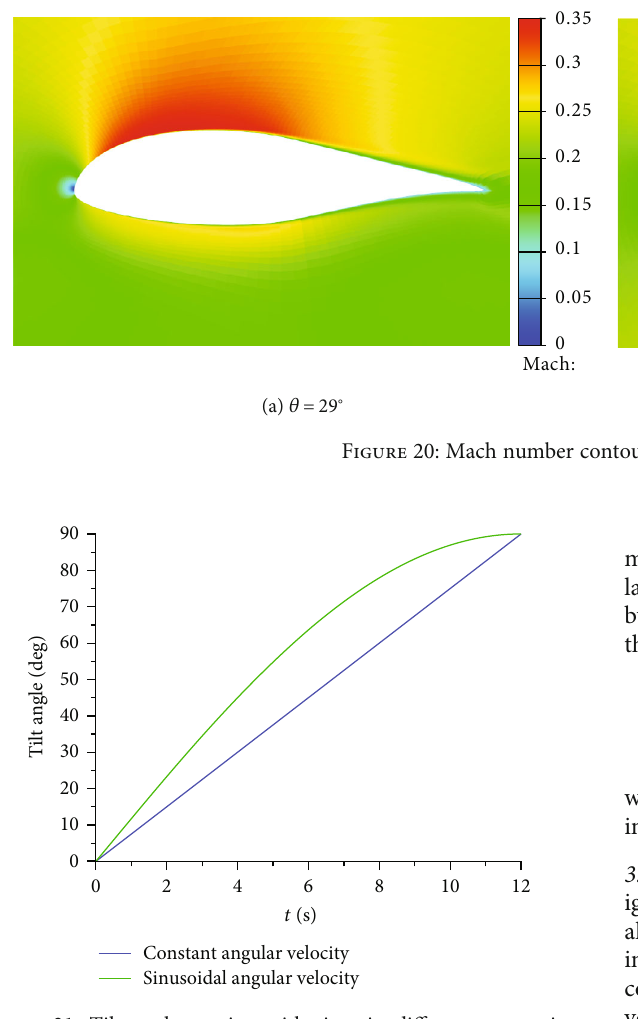
Figure 21: Tilt angle varying with time in di ff erent conversion